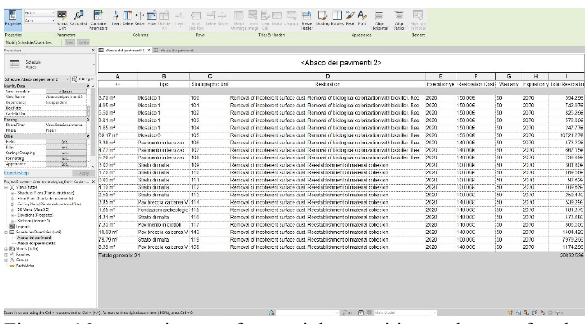
Figure 10: an estimate of material quantities and costs for the floor.